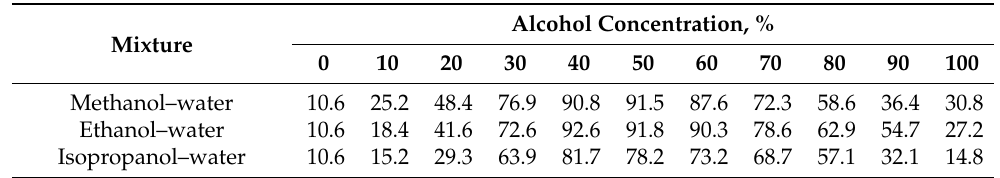
Table 4. Desorption ratio of total cucumber flower flavonoids on Amberlite XAD-2 after elution with alcohol-water mixtures.